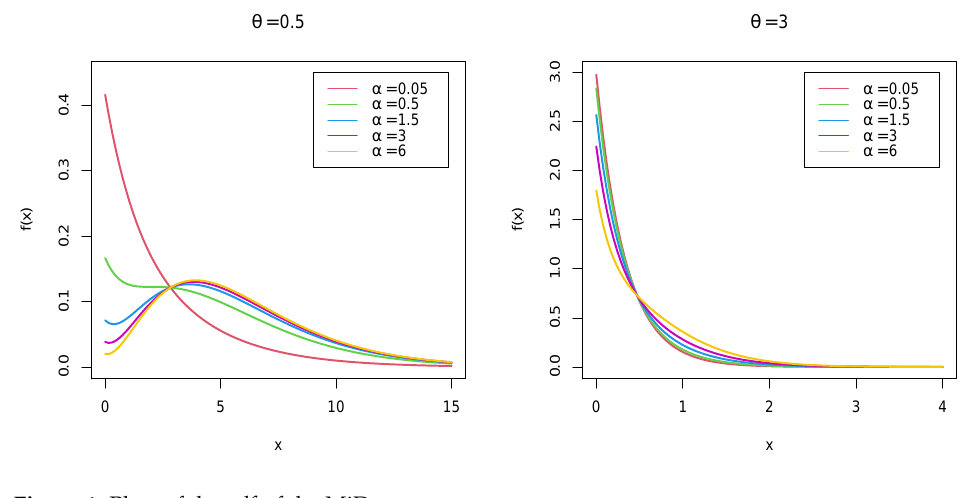
Figure 1. Plots of the pdf of the